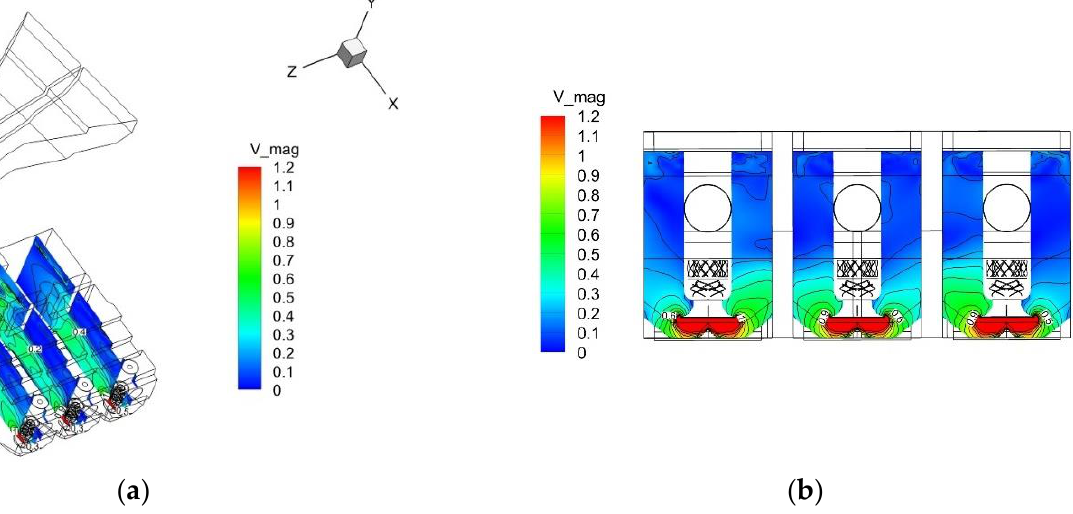
Figure 8. Plan 1 isogram of velocity. ( a ) Center section of pump body along flow direction. ( b ) Center section of pump body in vertical flow direction.